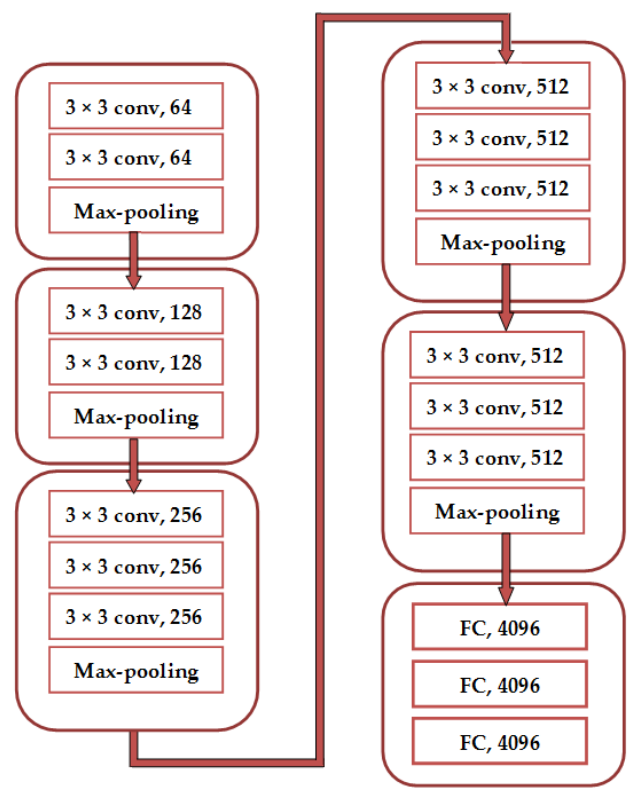
Figure 24. VGGNet architecture.